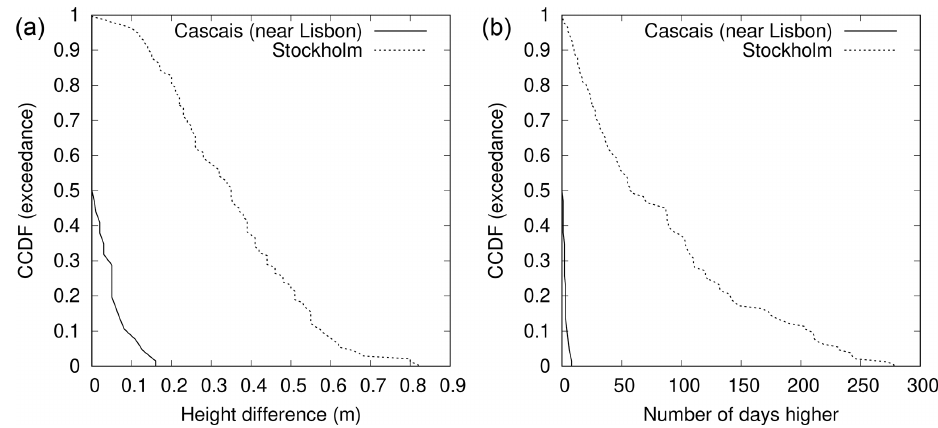
Figure 8. Complementary cumulative distribution functions (CCDFs) for Cascais (near Lisbon) and Stockholm. (a) Annual first metric , which is height of highest observed sea level above observed maximum on day of highest predicted tide for the year, for daylight days ( o d (I od (j,k),j,k) − o d (I pd (j,k),j,k) ), estimated over all valid years, j . (b) Annual second metric , which is no. of days when observed sea level, o d (i,j,k) , higher than observed maximum on day of highest predicted tide for the year, o d (I pd (j,k),j,k) , for daylight days , estimated over all valid years, j .